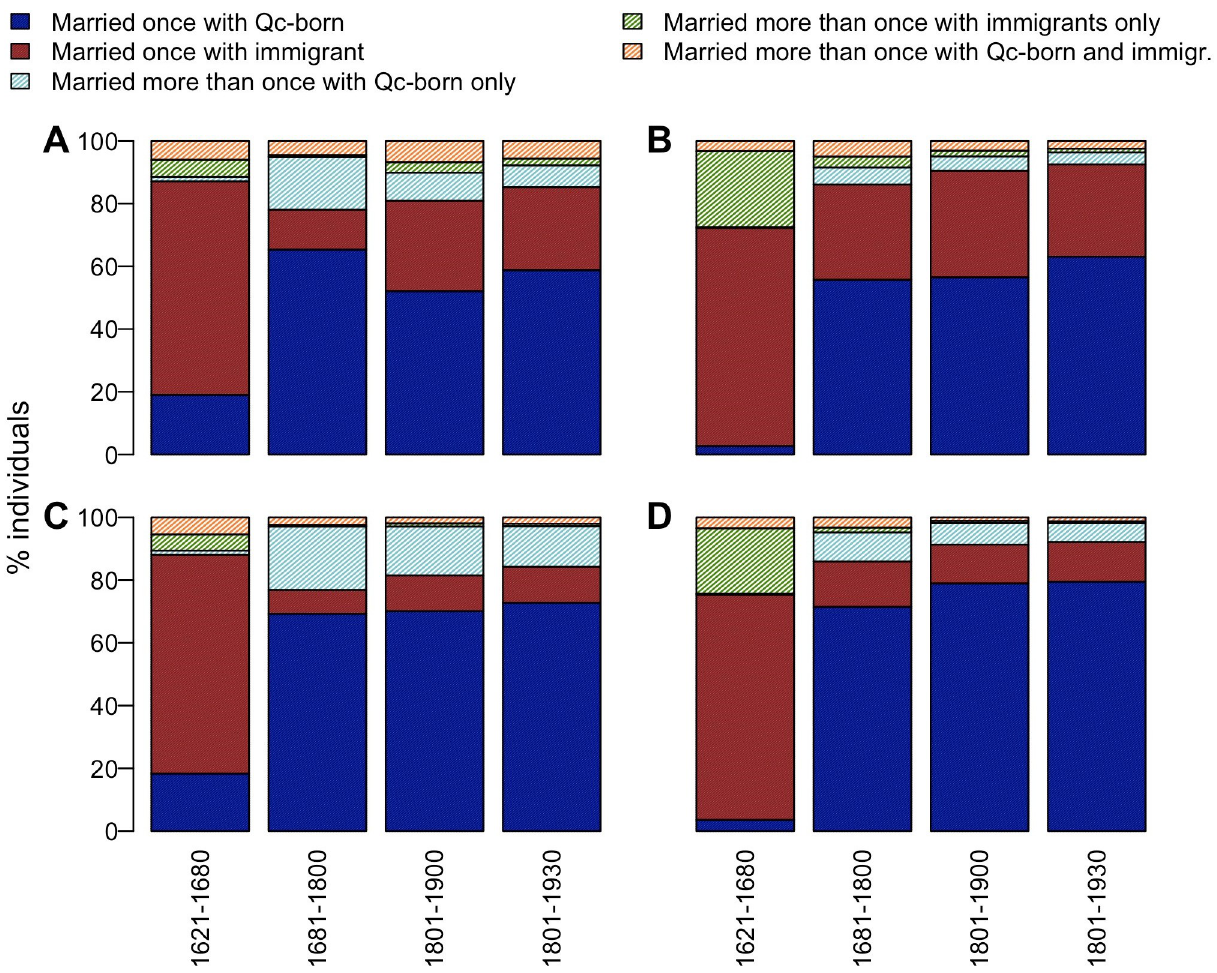
Fig 4. Distribution of marriages and remarriages among marrieds at four time periods. Different categories of marrieds are specified in the above histograms by their corresponding color codes. The contributing male and female immigrants are in A and B , respectively, whereas all (immigrants and Quebec-born) married men ( C ) and women ( D